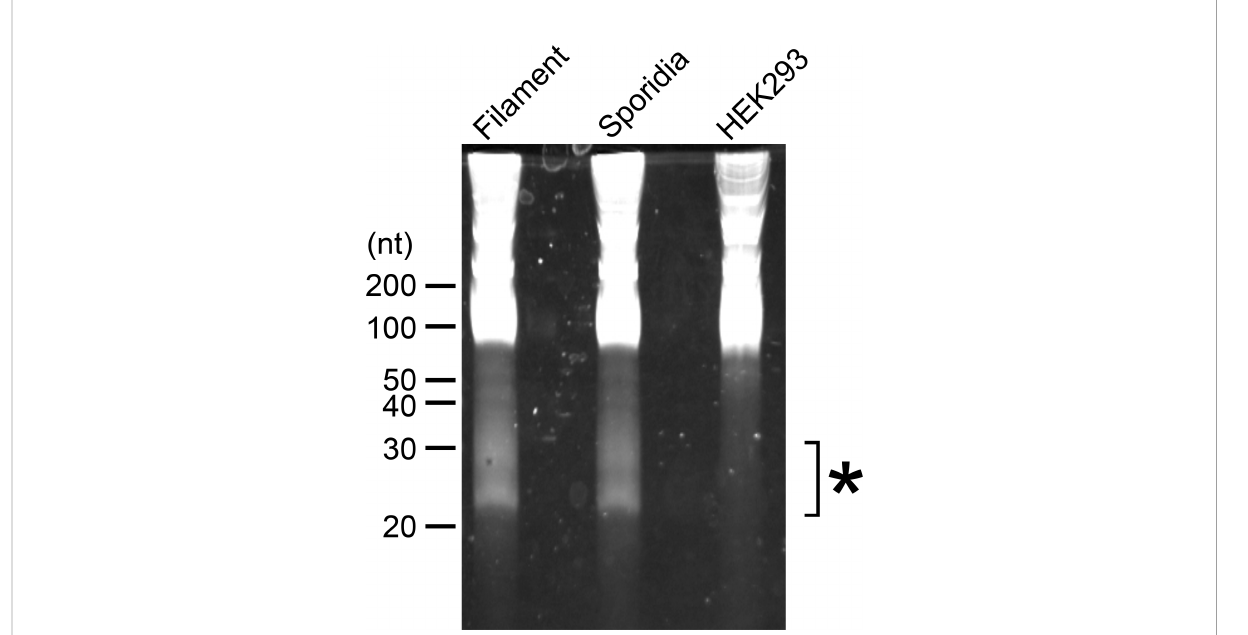
FIGURE 1 Electrophoresis of total RNAs extracted from U. maydis . RNA samples extracted from fi lamentous and sporidia cells of U. maydis AB33 strain were loaded on 15% denaturing PAGE containing 8 M Urea. Filamentous cells of AB33 were induced in NM-liquid medium and sporidia cells of AB33 were incubated in YEPSL. Total RNA from human HEK293 cells was loaded as negative control. Asterisk indicates the region used for the extraction of small RNA fragments from fi lamentous and sporidia cells and subsequent RNA-seq